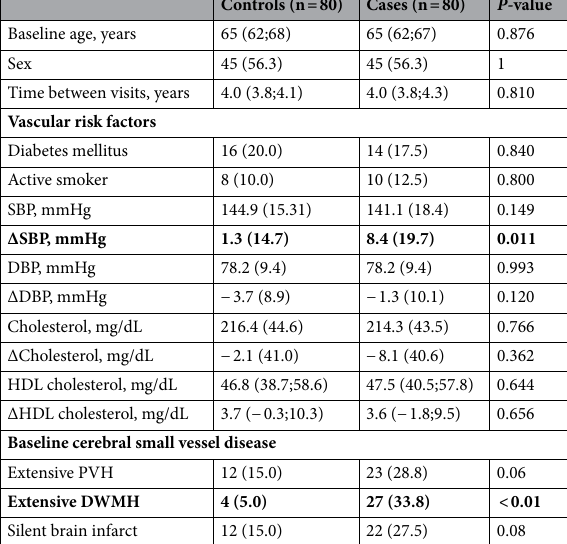
same associations as presented above, indicating that the relationship between these proteins and progression of WMH was not confounded by baseline WMH (Supplementary Fig. 3).